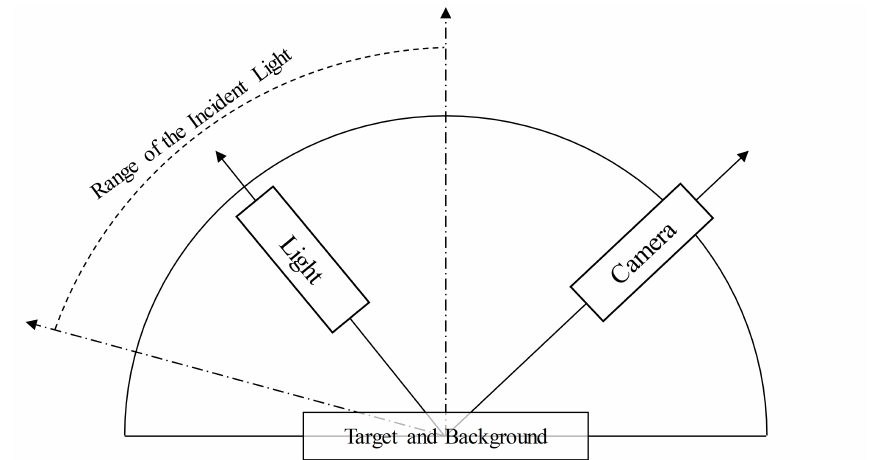
Figure 6. Diagram of the BRDF model measuring